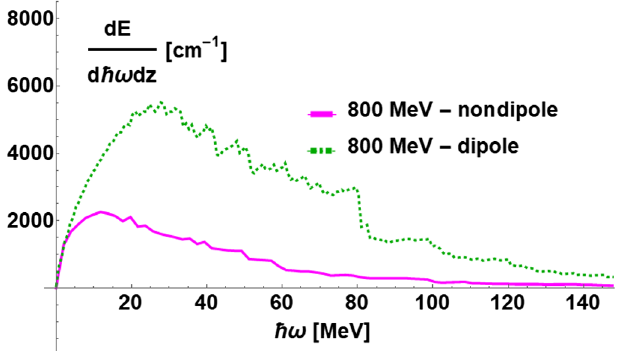
FIG. 5. Comparison of CR spectra calculated in the dipole and nondipole approximation for electrons of energy 2 GeV axially channeled along the h 100 i axis of a 20 - μ m-thick W single crystal at parallel incidence with respect to the crystal